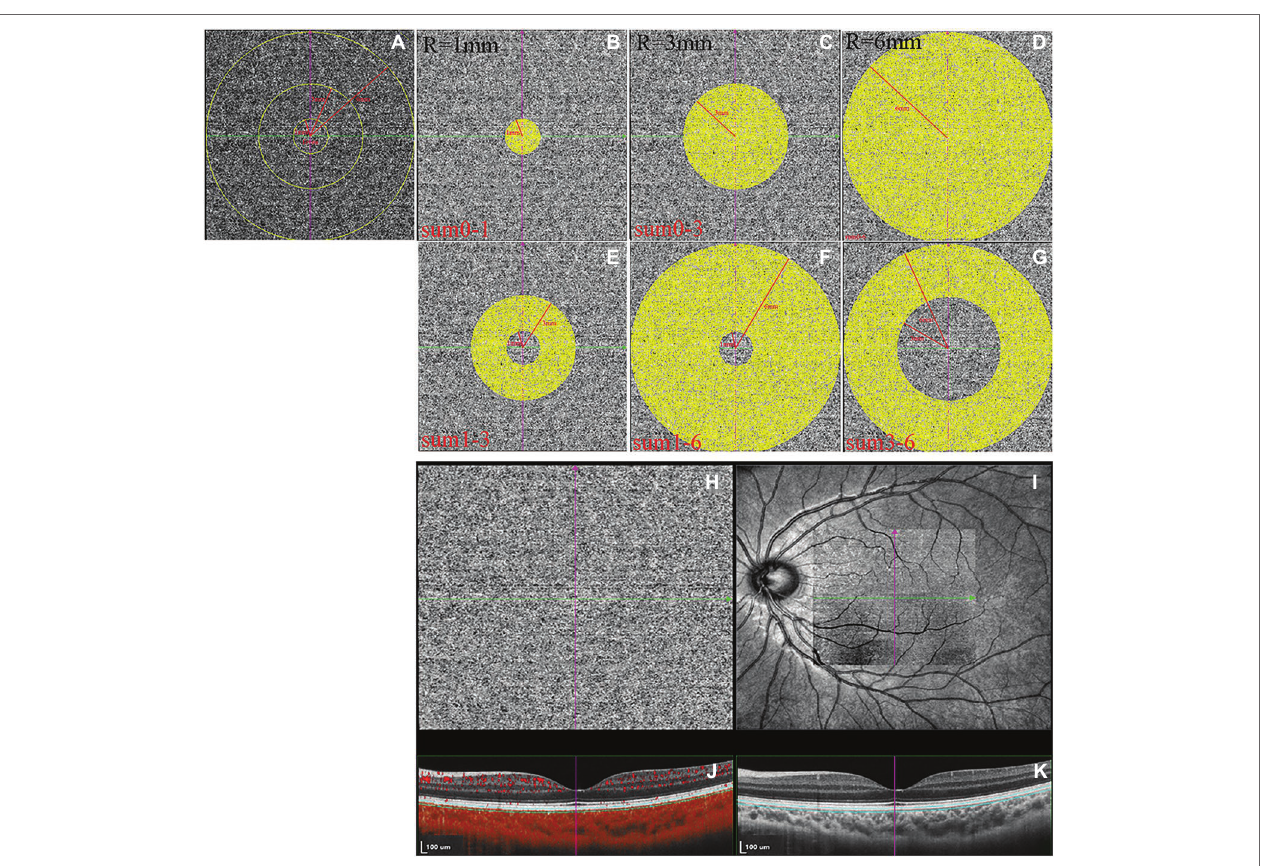
FIGURE 3 | The measurements of choriocapillaris luminal area (CLA). (A–G) The measurement ranges of CLA. (H) Magnified en face optical coherence tomography angiography (OCTA) choriocapillaris image. (I) OCTA scan region of 6 × 6 mm centering on fovea. (J) Structural optical coherence tomography (OCT)